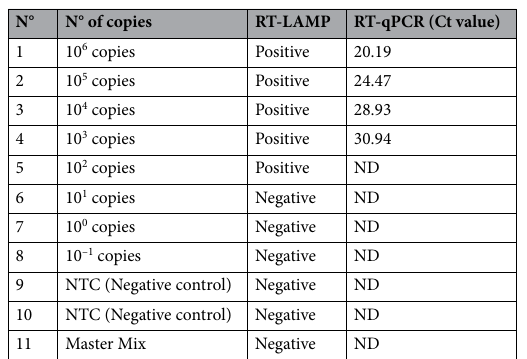
Table 2. Limits of detection of RT-qPCR and RT-LAMP assays for the detection of the RdRp gene. NoD No detected, NTC not template control.